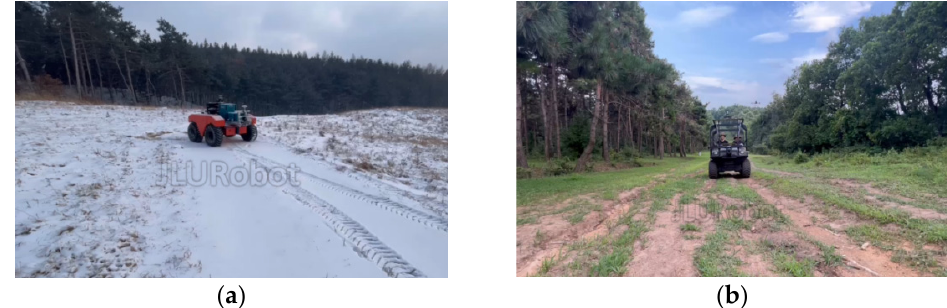
Figure 2. Data collection platforms from JLUROBOT team: ( a ) J5; ( b ) Avenger.